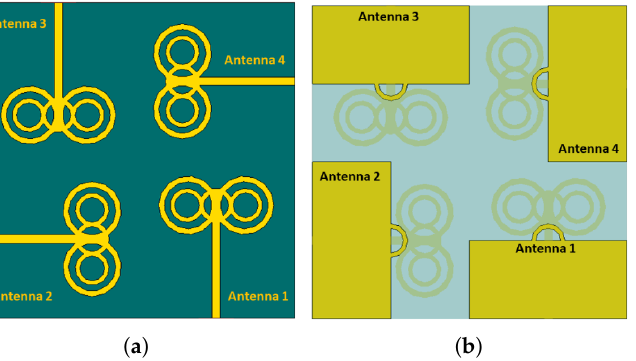
Figure 2. Multiple Input–Multiple Output (MIM) configuration. ( a ) View of the front; ( b ) view of the